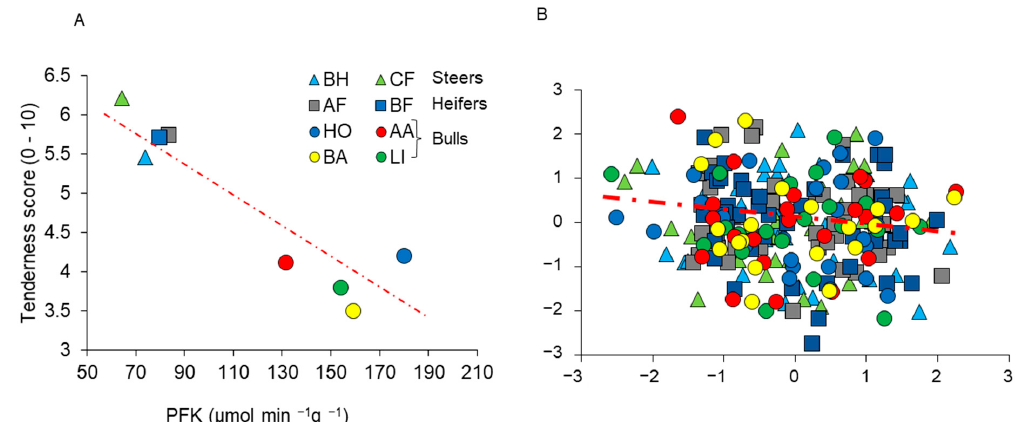
Figure 9. Example of correlation between muscle characteristics and beef quality traits. ( A ) Average values of phosphofructokinase (PFK; glycolytic enzyme) and tenderness score are strongly negatively correlated ( r = − 0.92; p < 0.0001) when using average values of different animal types. ( B ) However, when Z-scores are used, removing the effects of animal type, the correlation is nonexistent ( r = − 0.06; NS), indicating that PFK activity was not directly related to tenderness [88] . Animals were steers: 40 Belgian-Blue × Holstein (BH) and 32 Charolais crossbred (CF) reared in the United Kingdom; heifers: 47 Angus × Friesian (AF) and 47 Belgian-Blue × Friesian (BF) reared in Ireland; young bulls: 25 Holstein (HO) reared in Germany, and 24 Angus (AA), 25 Limousin (LI), and 25 Blond d’Aquitaine (BA) reared in France. Higher tenderness scores indicate greater tenderness.